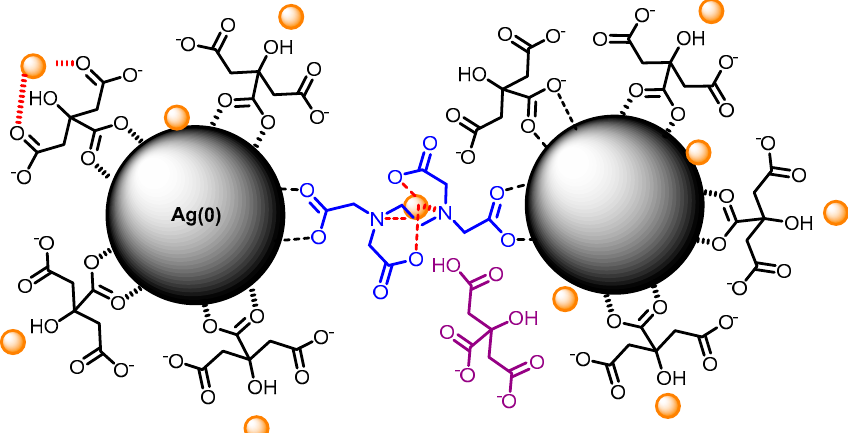
Figure 6. A speculated scheme of Cr (III) coordination with citrate and EDTA on AgNPs surface. Small orange spheres represent Cr (III), molecules in blue represent the EDTA chelator in complex with Cr (III), molecules in black color represent the citrate capping the AgNPs, molecule in purple color represents citrate after being released from AgNPs surface.